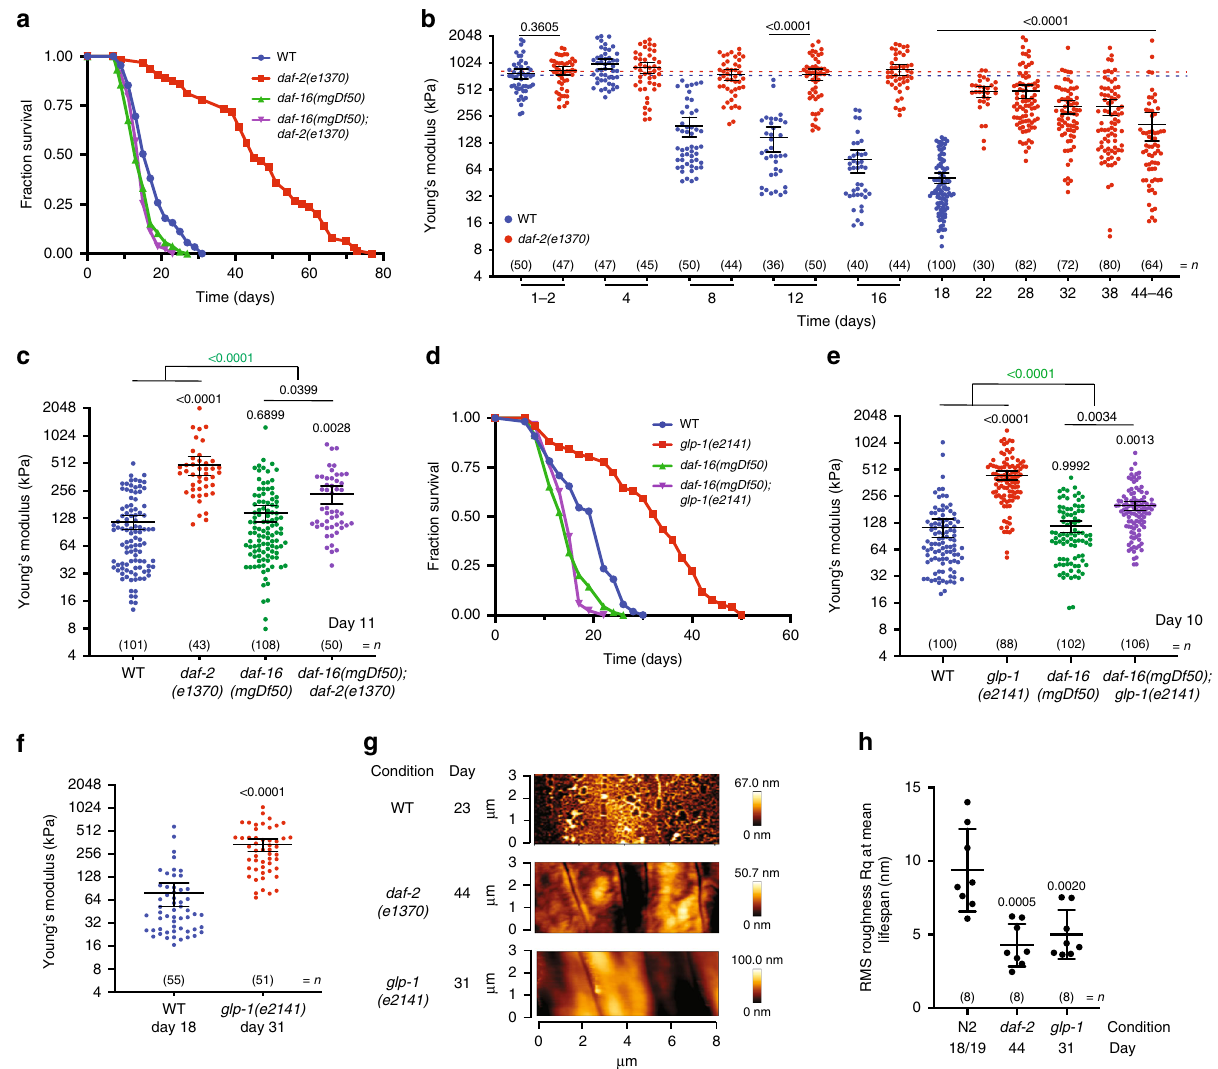
Fig. 2 Reduction of the insulin signalling pathway increases lifespan, improves stiffness and reduces cuticle senescence with age. a Lifespan curve of wild-type (WT) (blue), or daf -2 (red), daf - 16 (green), daf - 16;daf - 2 (purple) mutant C . elegans . ( n = 89, 64, 105 and 79, respectively; log rank test p < 0.001 vs WT). b Longitudinal study of mechanical properties as Young ’ s Modulus (YM; kPa) comparing WT (blue) and daf - 2 mutant (red) C . elegans until mean lifespan (D18 for WT; D44/46 for daf - 2 ). Error bars indicate 95% CI, dotted line marks mean YM at day 1 for WT (blue) and daf - 2 (red). Two-tailed unpaired t test for statistical comparison of WT to daf - 2 at chronological age day 1, 12 or at mean lifespan. c Mechanical properties as YM (kPa) of WT (blue), daf - 2 (red), daf - 16 (green) and daf - 16;daf - 2 (purple) mutant C . elegans at chronological age of 11 days. Error bars indicate 95% CI. Two-way ANOVA Tukey ’ s multiple comparison test for statistical comparison and interaction of terms (green). d Lifespan curve of WT (blue), glp - 1 (red), daf - 16 (green) and daf - 16;glp - 1 (purple) mutant C . elegans . ( n = 55, 76, 69 and 88, respectively; log rank test p < 0.001 vs WT) and e mechanical properties as YM (kPa) at chronological age of 10 days. Two-way ANOVA Tukey ’ s multiple comparison test for statistical comparison and interaction of terms (green). f Mechanical properties as YM (kPa) of WT (blue), or glp - 1 (red) mutant C . elegans at mean lifespan. Two-tailed unpaired t test was used for statistical comparison. g Representative AFM cuticle topography images of WT, daf - 2 or glp - 1 mutant at mean lifespan and h roughness quanti fi cation of topographical images presented as RMS roughness Rq ± standard deviation. Two-tailed unpaired t test for statistical comparison of WT with mutants. n represented above the graph, show number of biologically independent worm samples. For lifespan measurements, n represents the number of worms scored as dead. For a summary of YM values and additional statistics for independent trials see Supplementary Data 1 and for a summary of worm lifespan trials and statistical comparison between genotypes see Supplementary Data 2. Source data are provided as a Source Data fi